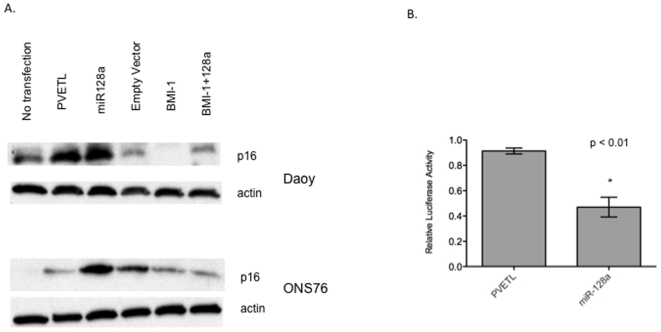
Growth inhibition signaling pathways modulated by miR-128a.A) Western blot analysis showed increased p16 expression in Daoy cells transfected with miR-128a compared to that of the control vector, pVETL. The level of p16 expression was completely inhibited in Daoy cells that were transfected with the Bmi-1 vector alone while modest inhibition was observed in cells co-transfected with miR-128a. B) Decreased E2F1 activity in Daoy cells transfected with miR-128a as measured by luciferase reporter assays. (p<0.01)